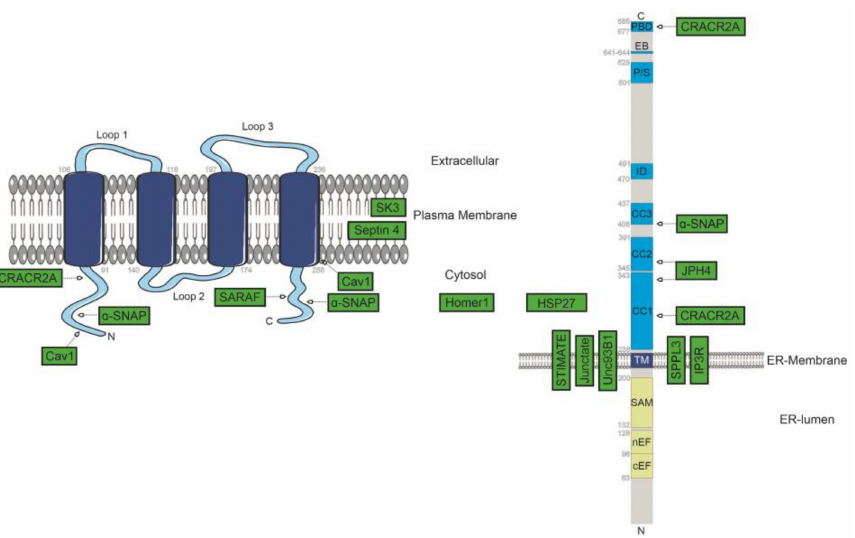
Figure 1. Identified positive regulators of SOCE. Known protein-localisation together with potential identified interaction sites between STIM1/Orai1 and regulatory-interacting proteins are represented in green